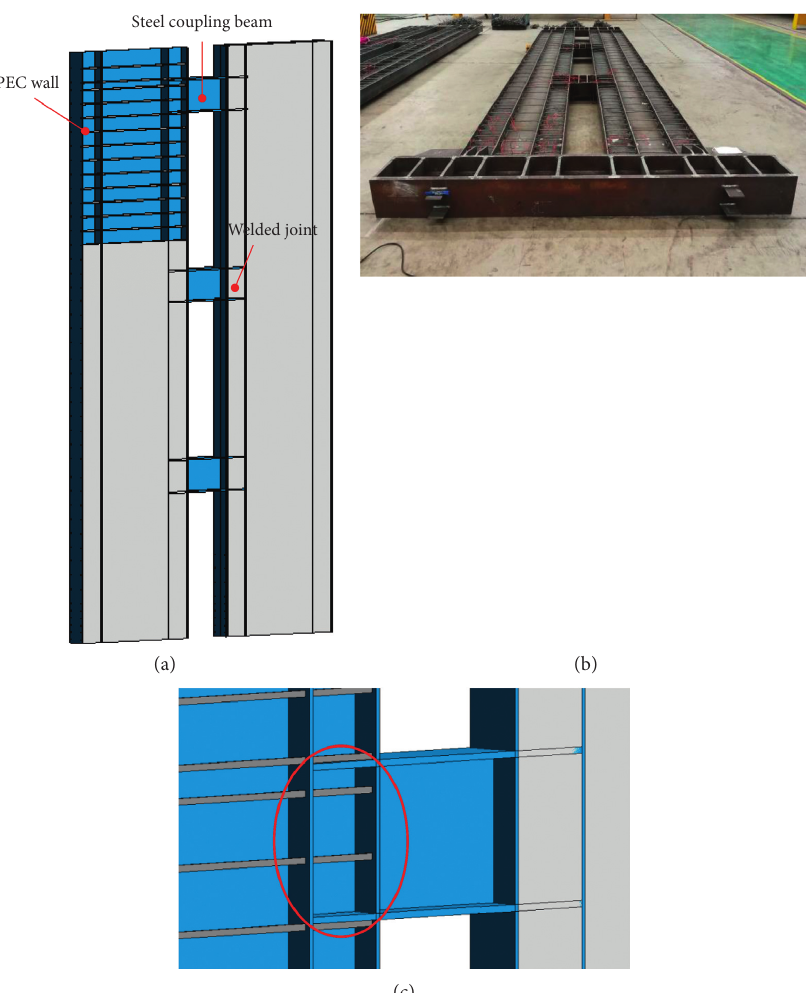
Figure 3: (a) Hybrid coupled PEC wall. (b) Steel component of the test. (c) Details of an innovative welded